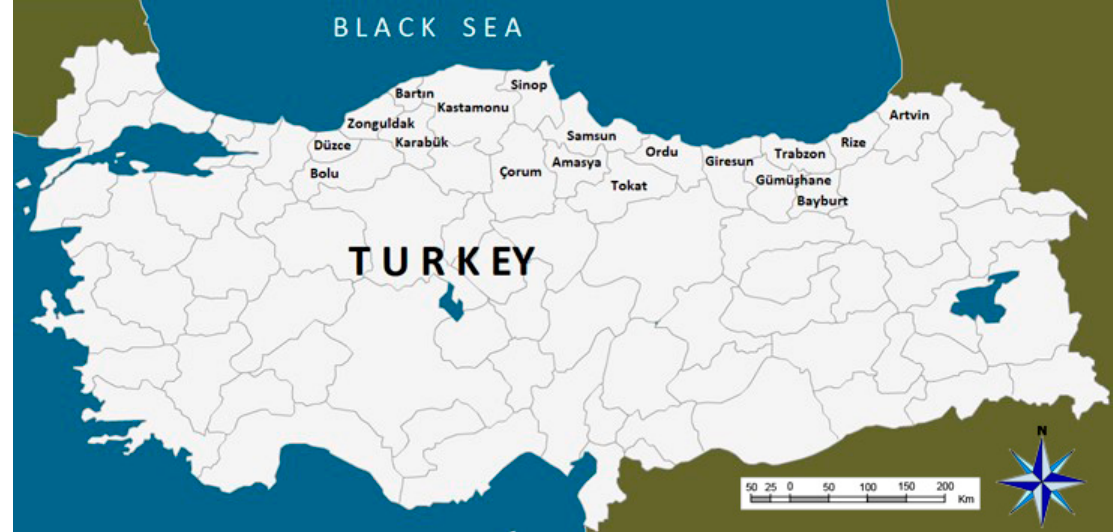
Figure 1. Locations of precipitation gauging stations used in the study.